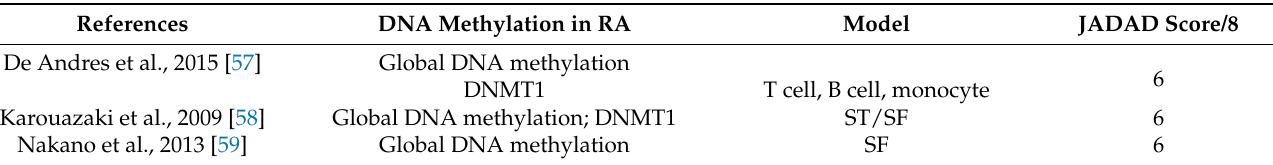
Table 2. Characteristics of the studies included in the DNA methylation meta-analysis.